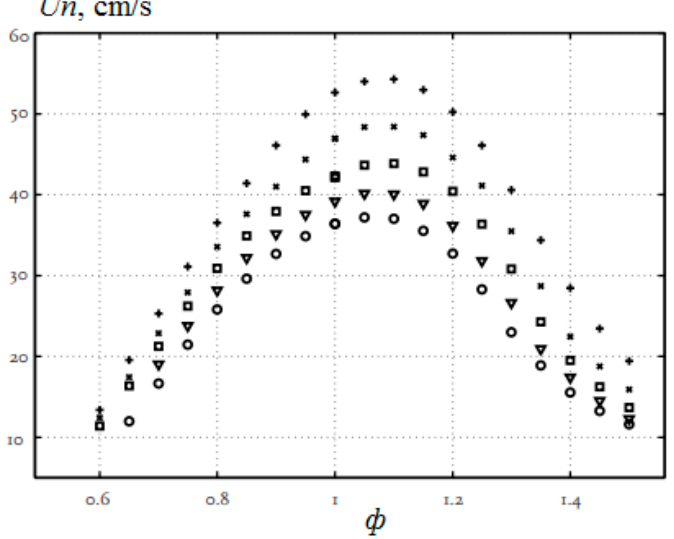
Figure 4. Dependence of the normal flame velocity Un of hydrogen–methane–air mixtures on the equivalence ratio φ under normal conditions. The hydrogen concentration: о —0%; ▽ —10%; □ —20%; x—30%; +—40% (Adapted from ref. [17]).